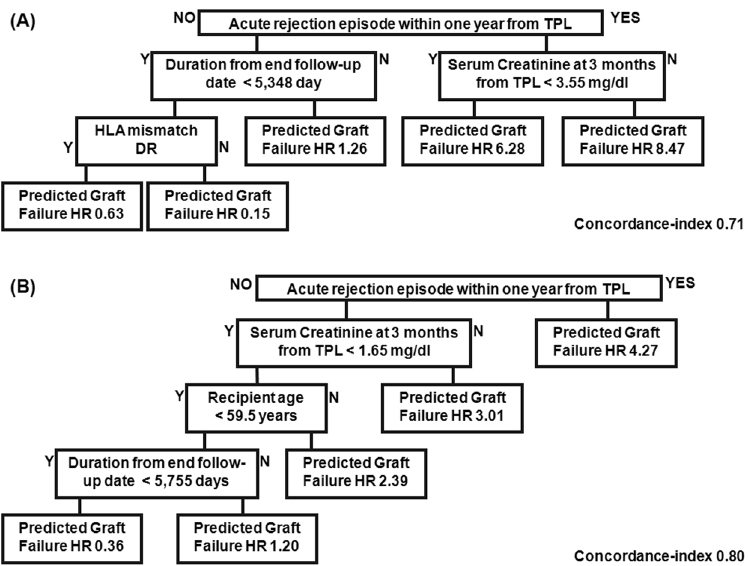
Figure 3. The graft survival prediction tree using survival hazard ratio modelling. Decision tree using the training, test and validation data set, after stratified sampling using survival statics, with ‘Y’ indicating a positive conclusion and ‘N’ a negative conclusion. The graft failure risk is presented as a survival hazard ratio (HR). ( A ) Model setting 1: Use overall attributes with multiple imputation. ( B ) Model setting 2: Use attributes except DSA,